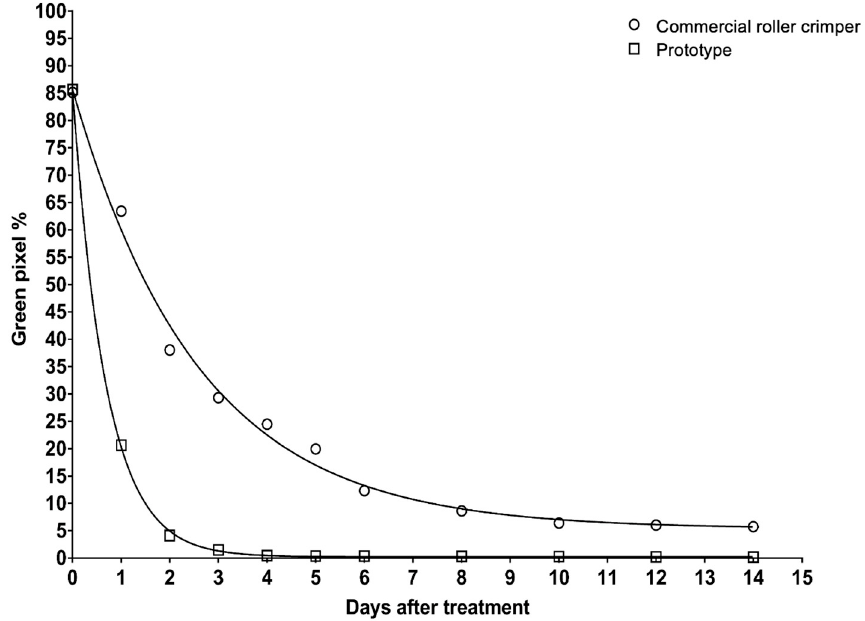
Figure 4. Monophasic exponential nonlinear regression curves of the % of green pixels in the digital